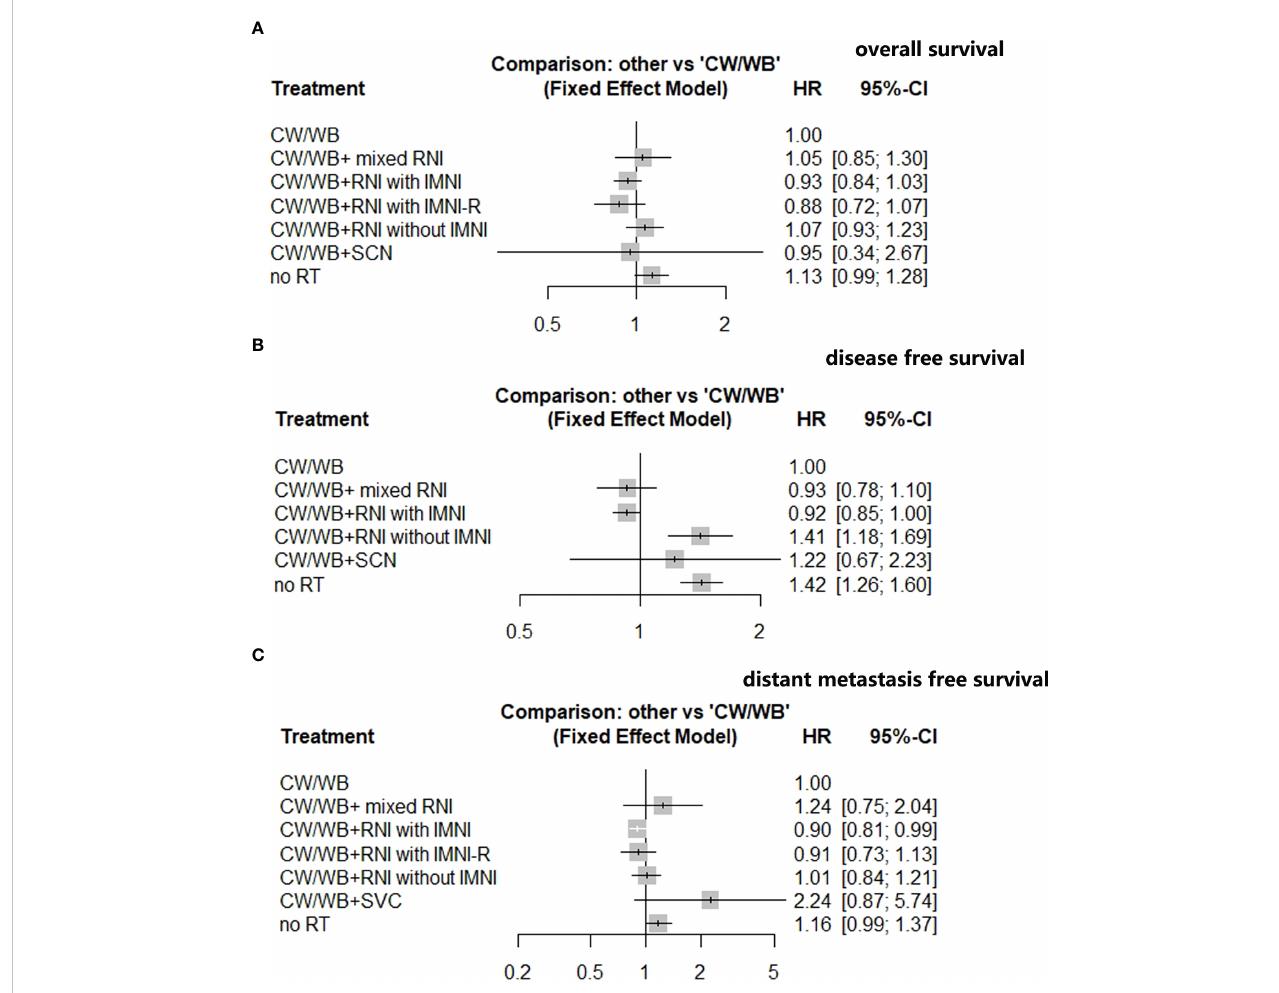
FIGURE 4 Network analysis of different RNI volume versus CW/WB alone early-stage BC. (A) OS; (B) DFS; (C)